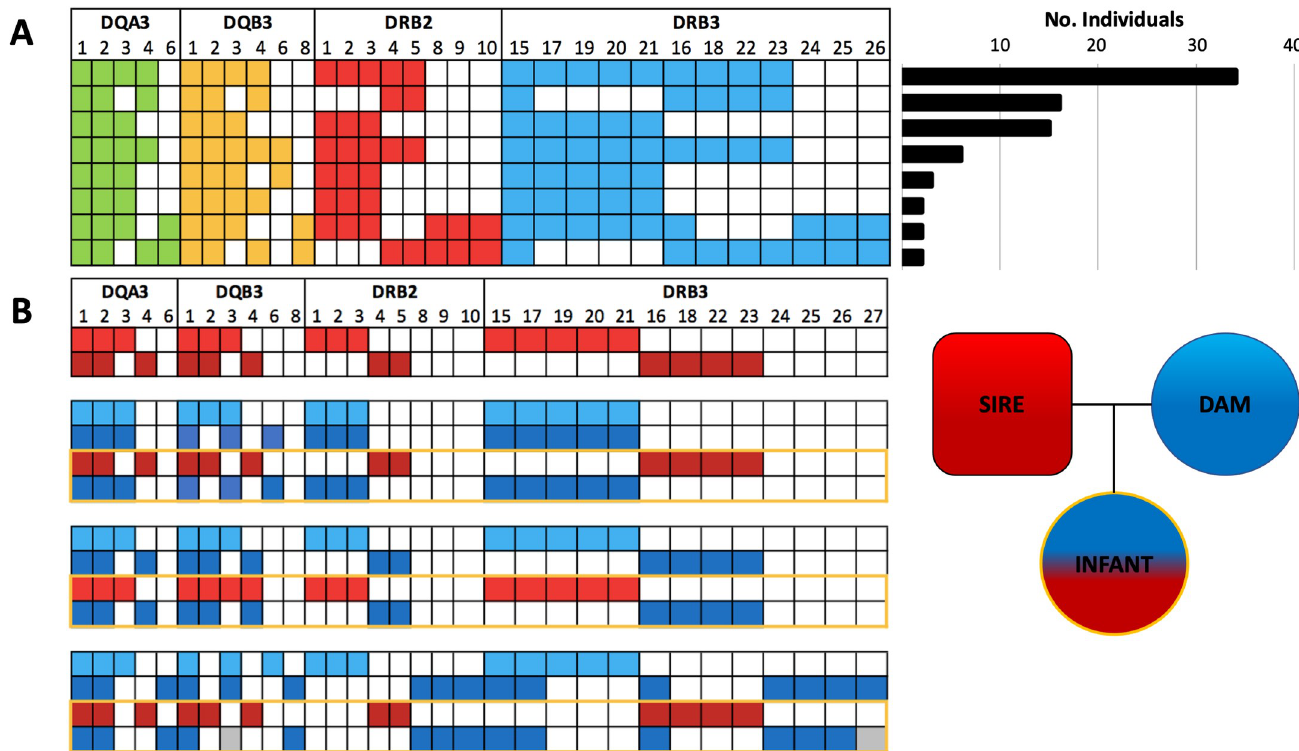
Fig 3. Genotype variation in the SSR population of Cebus imitator . (A) Diploid genotypes shared by two or more individuals. Only individuals successfully genotyped for all four exons are included (N = 97). (B) Illustration of genotype inheritance in the SSR C . imitator population based on our MHC genotypes as compared to known pedigrees in the population. Diploid genotypes are shown for three triads: A single male sire, three females with whom he sired offspring, and the respective resulting offspring. The two different shades of red (for the male) and blue (for the females) in the parental genotypes represent each individual’s two distinct haplotypes (which are identical if the individual is homozygous). Offspring genotypes (within yellow outline) are combinations of inherited paternal (red) and maternal (blue) haplotypes. Genotyping based on our quality control measures almost always shows expected patterns of inheritance that are consistent across all four exons (i.e. allele sets across all four exons are inherited together as a ‘block’). Gray boxes indicate potential allelic dropout due to failed amplification during PCR or erroneous removal during quality control.